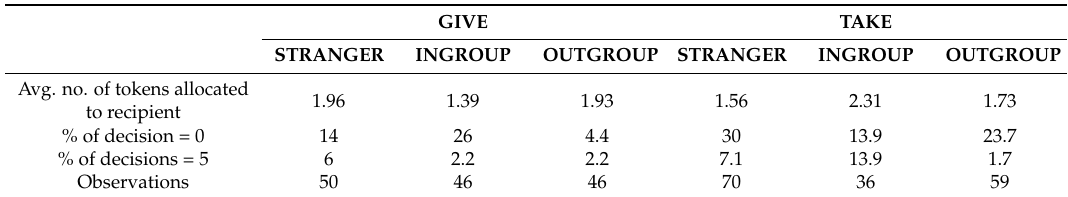
Table 3. Endowments allocated to recipient: mean values and number of participants (in parenthesis) across treatments. GIVE TAKE STRANGER INGROUP OUTGROUP STRANGER INGROUP OUTGROUP